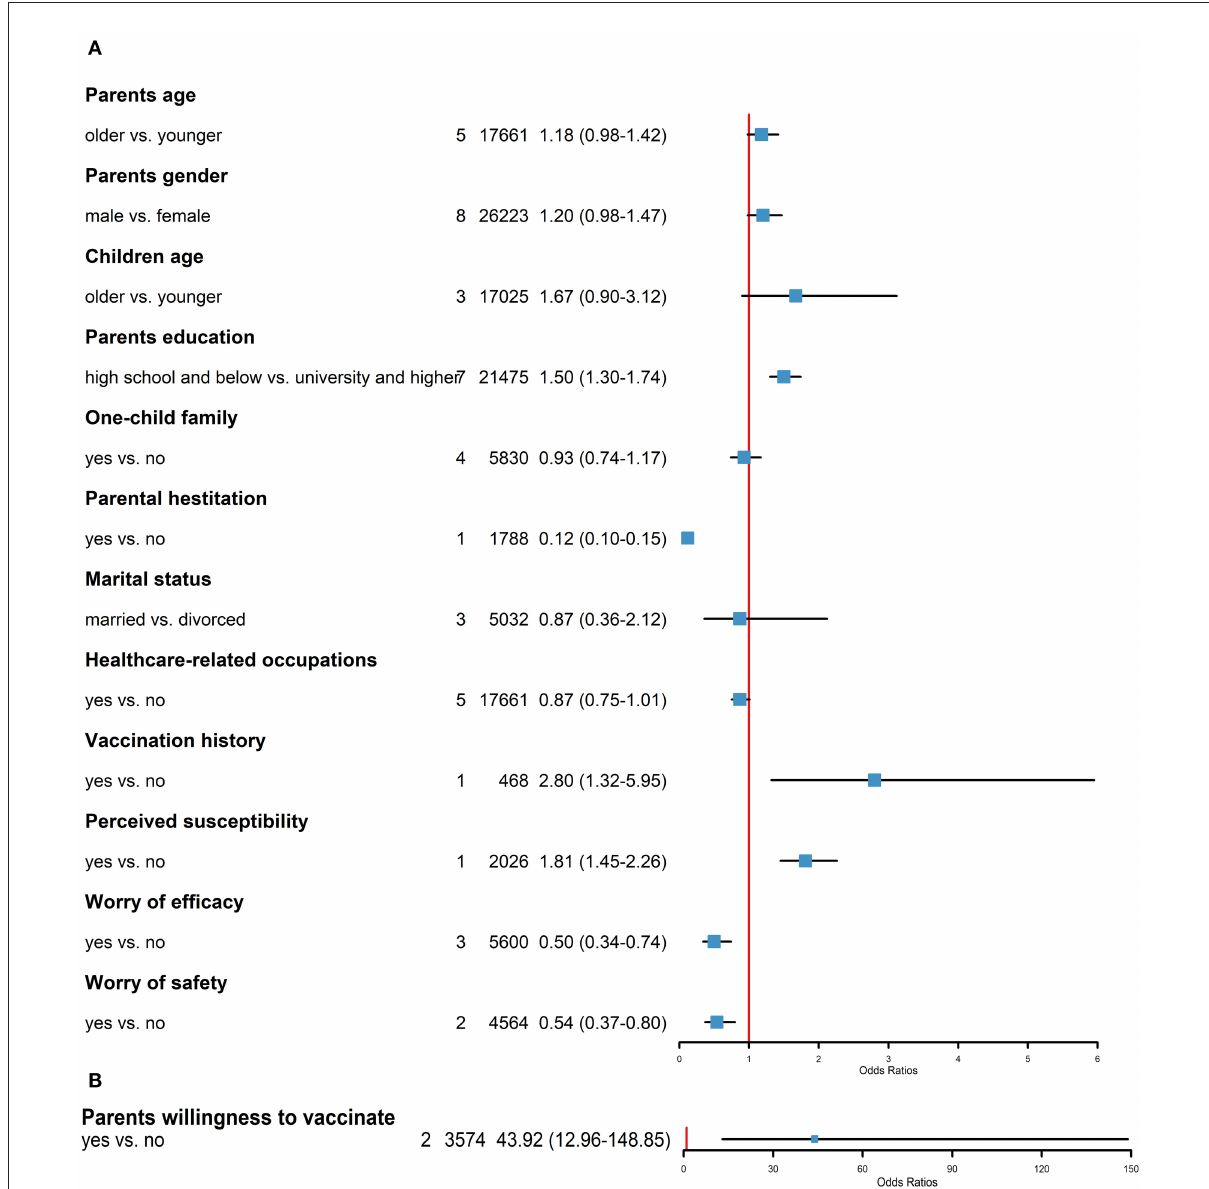
FIGURE3 Predictors of Chinese parents’ willingness to vaccinate their children against